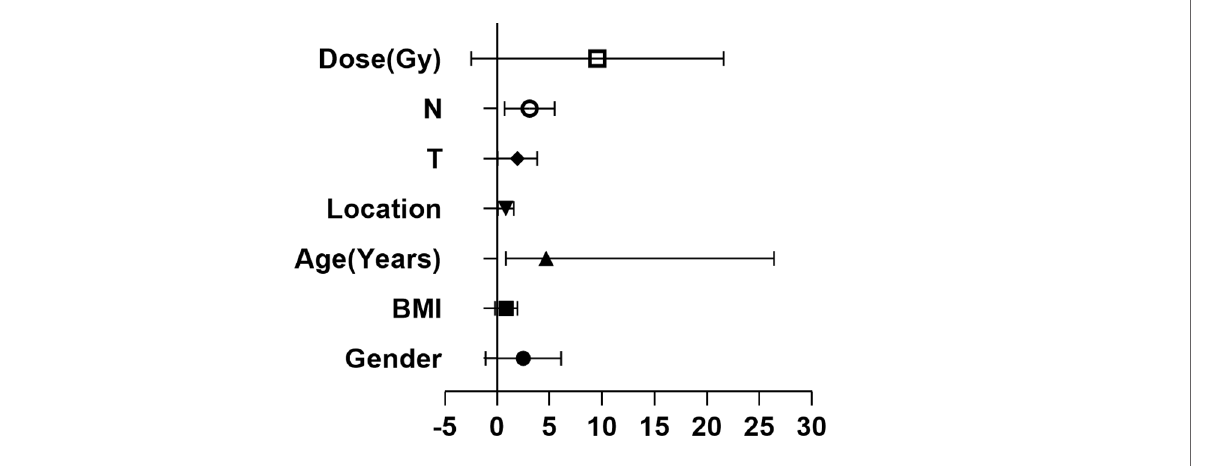
FIGURE 5 | Relationship between clinical parameters and ef